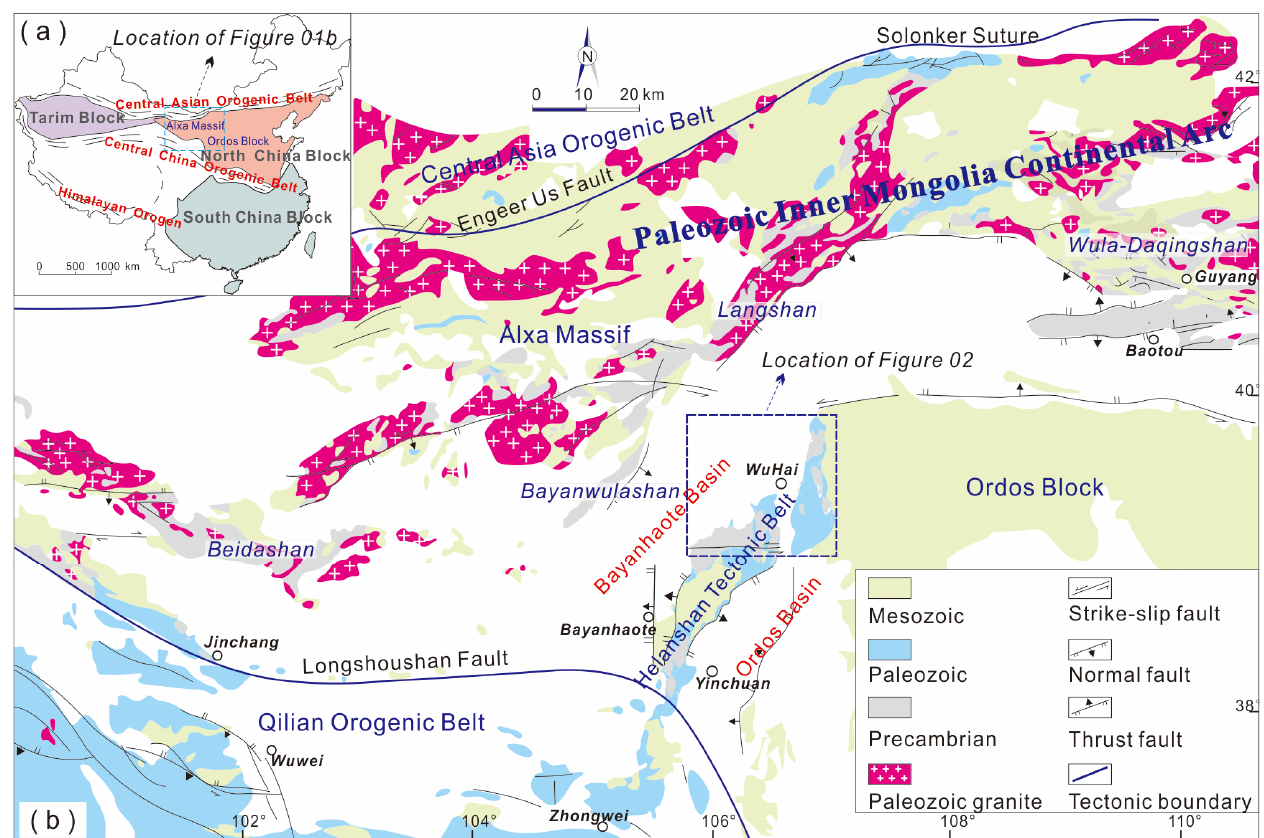
Figure 1. ( a ) Simplified map illustrating tectonic framework of the China mainland; ( b ) Tectonic overview map of the western North China Block showing the location of the Alxa Massif, Ordos Block, and the Paleozoic Inner Mongolia Continental Arc [2].